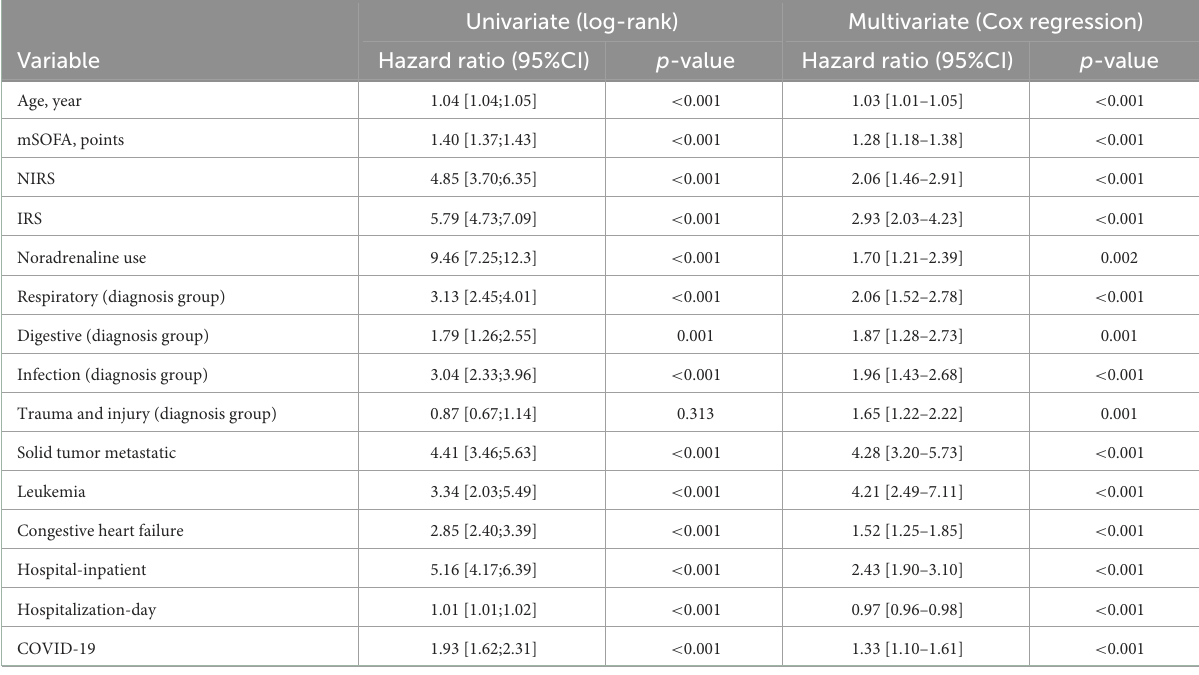
TABLE 5 Factors associated with mortality (univariate and multivariate by Cox regression) for the whole cohort.